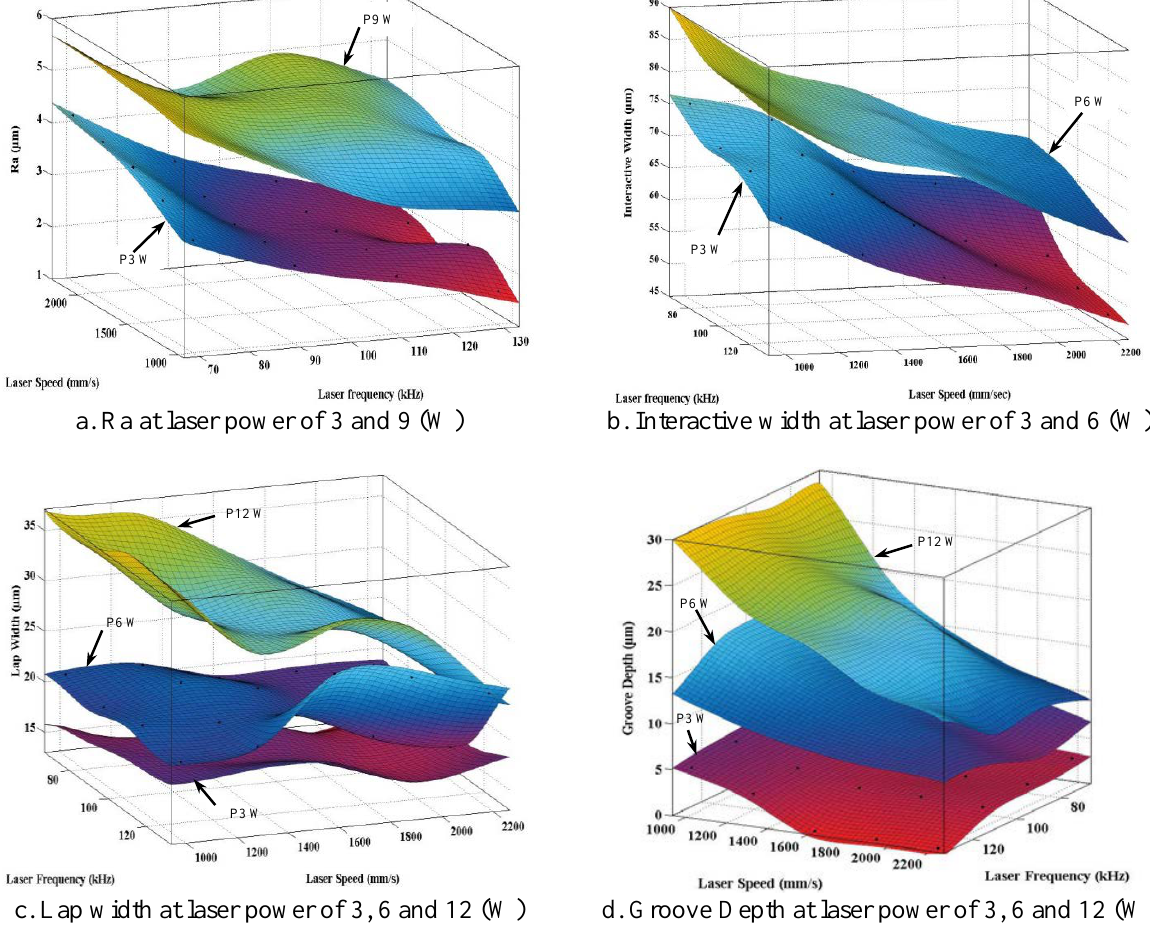
Fig. 10. The effect of the laser power, laser speed and laser frequency on the process